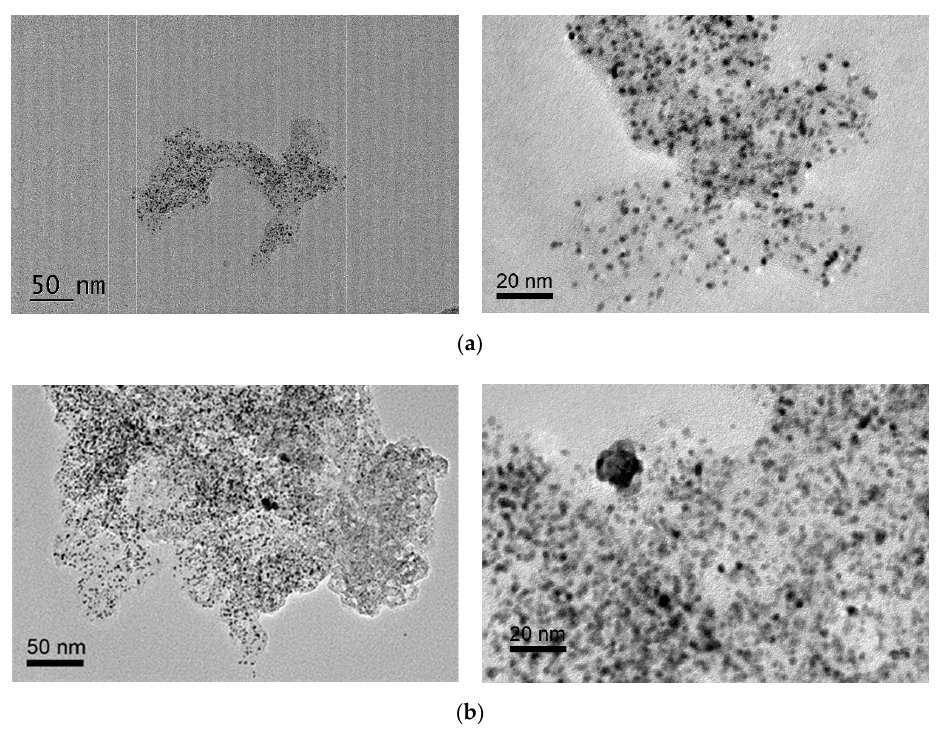
Figure 7. TEM images of ( a ) Pt/B-ECP600 and ( b ) Pt/ECP600 after 5K cycles of ADTs.